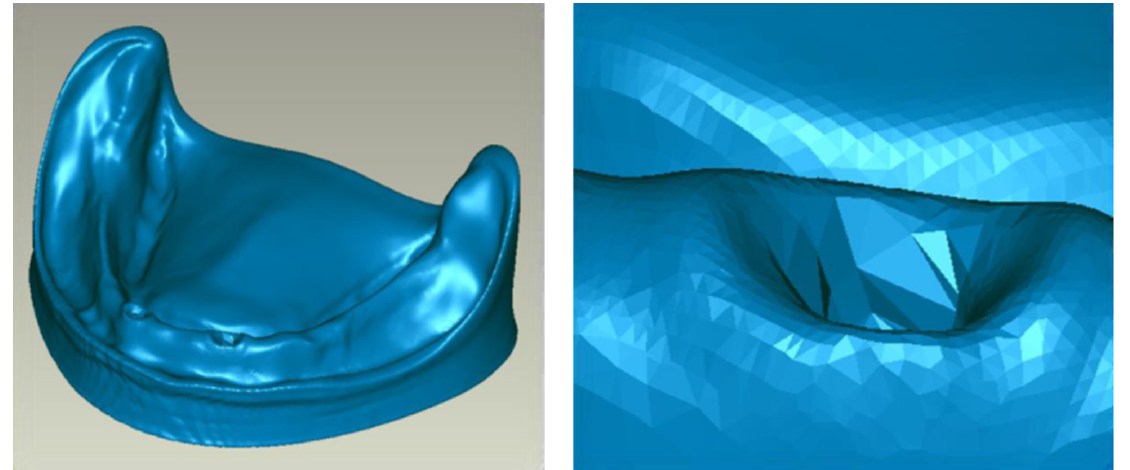
Figure 3. Mandibular mucosa geometry defined with a surface triangle mesh. The obtained surface triangle mesh was subjected to further processing. Finite Ele- ments Analysis (FEA) programs used for analysis require defining geometry as volumetric objects. For that, the next step involved changing the description of the mandibular mucosa geometry from surface triangle mesh to an object defined with Non-Uniform Rational Basis Spline (NURBS) type surfaces (see Figure 4).